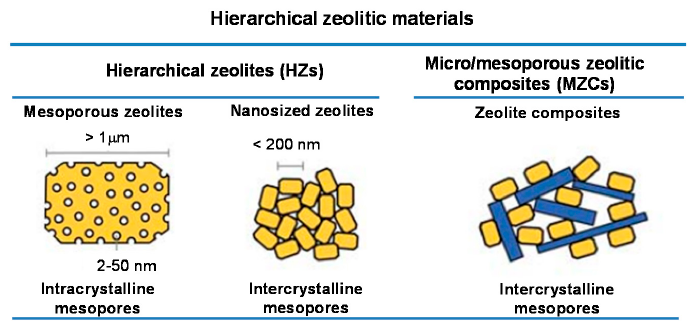
Figure 2. Categorization of hierarchical zeolitic materials that couple the advantages of both mesoporous materials and microporous crystalline zeolites. Adapted with permission from [10]. Copyright Royal Society of Chemistry, 2008.